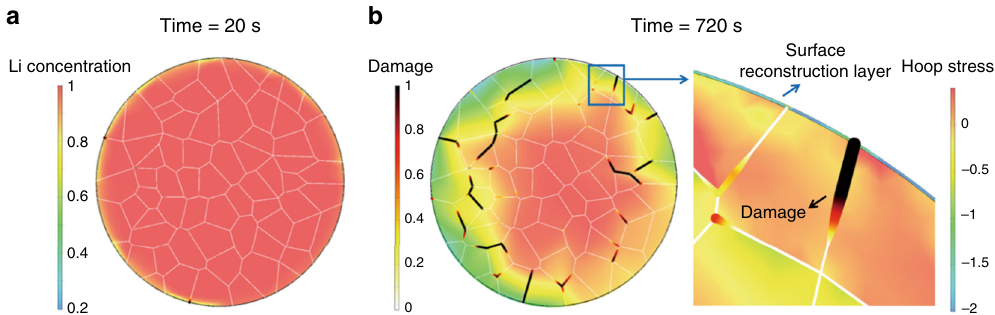
Fig. 5 FEM of surface passivation and structural decohesion in an NMC secondary particle. The Li concentration and intergranular damage at two charging times t = 20 s ( a ) and t = 720 s ( b ). The enlarged inset in b shows an overall compressive hoop stress in the passivation layer and an intergranular crack passing through the passivation layer.